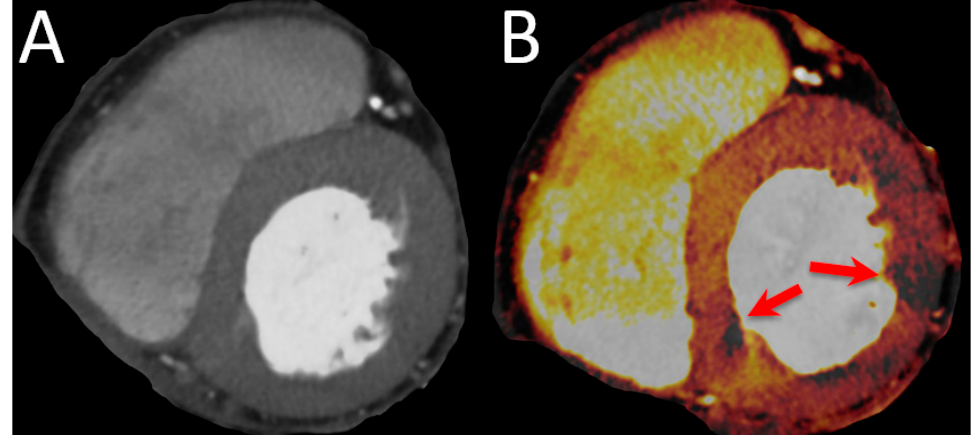
Figure 4. Imaging example of a CTP. A 78-year-old female patient with atypical angina and inter- mediate pretest probability. ( A ) shows the multiplanar reconstructions of the basal short axis with a DECT at 90 kV and 150 kV. ( B ) shows the perfused blood volume which is reduced in two segments (red arrows).